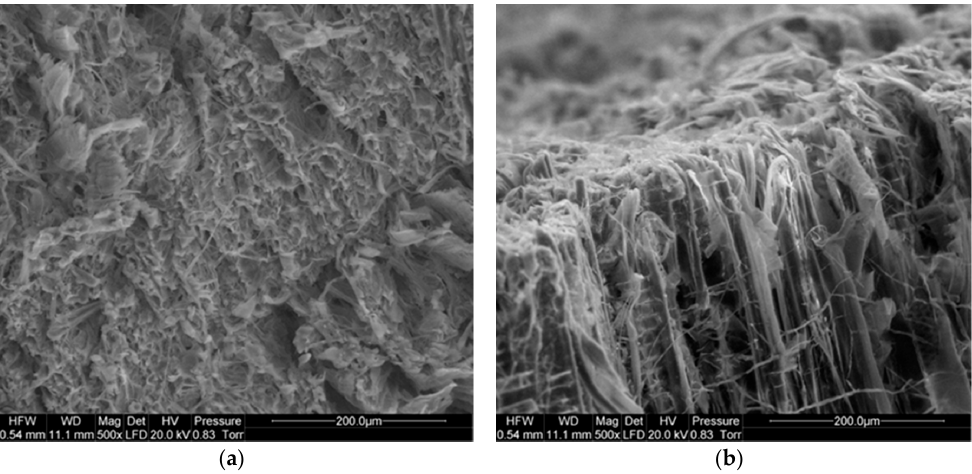
Figure 5. SEM image of a shear-cut surface of black poplar: ( a ) transverse section, ( b ) longitudinal section.